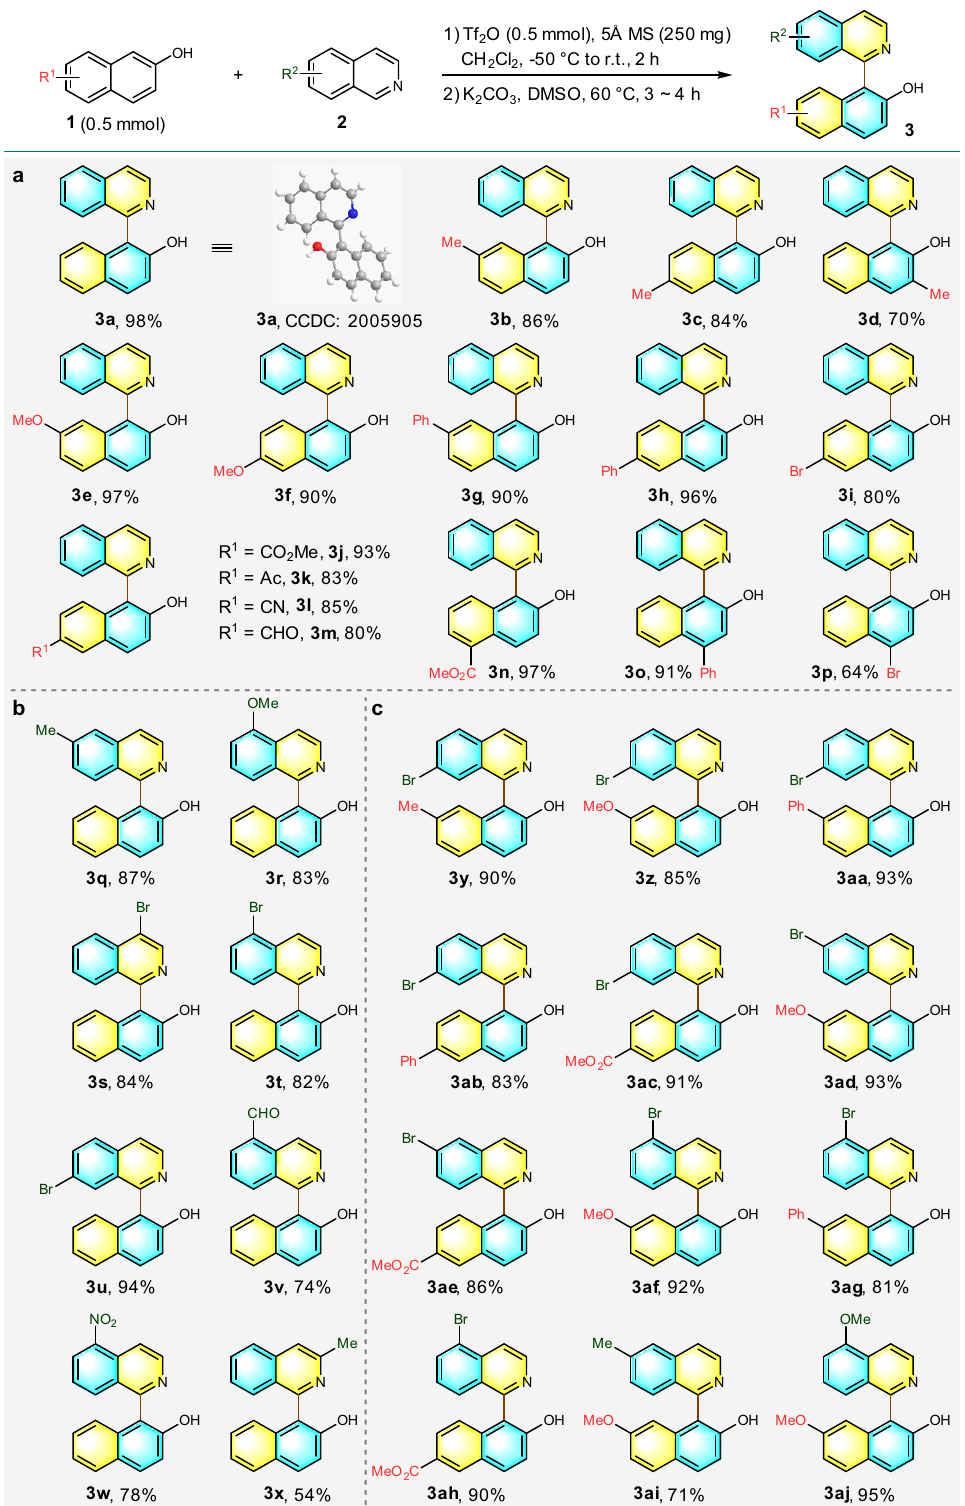
Fig. 4 Substrate scope of the oxidative cross-coupling of 2-naphthols and isoquinolines. a Scope of 2-naphthalenol. b Scope of isoquinoline. c Modi fi cation of both coupling